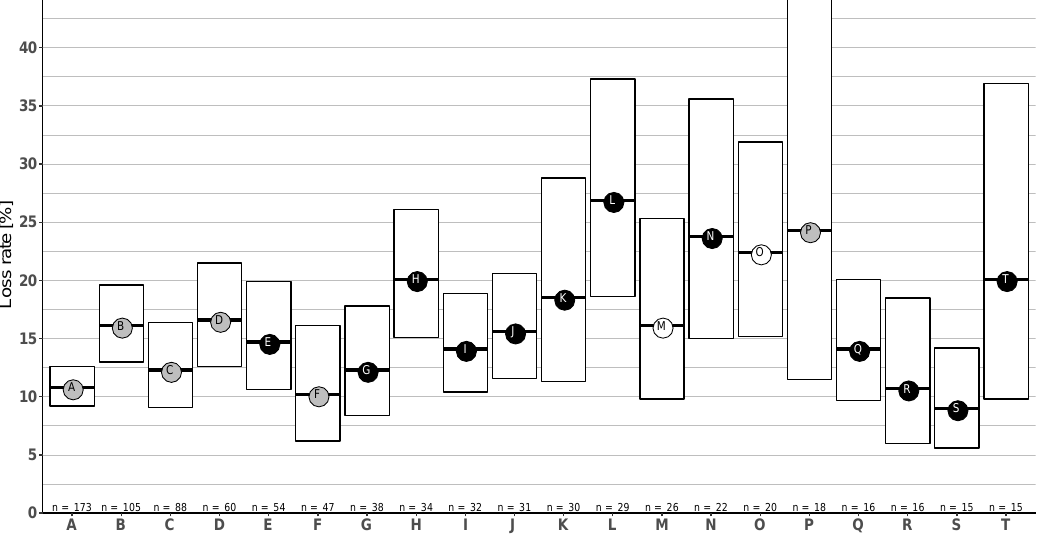
Figure 12. Winter honey bee colony loss rates (and 95% CI) resulting from combinations of various varroa control methods ordered by number of participants using the given combination: The point fill colour represents the number of different methods (single method = white, two methods = gray, and three methods = black). Please refer to Table 2 for explanation of the combination